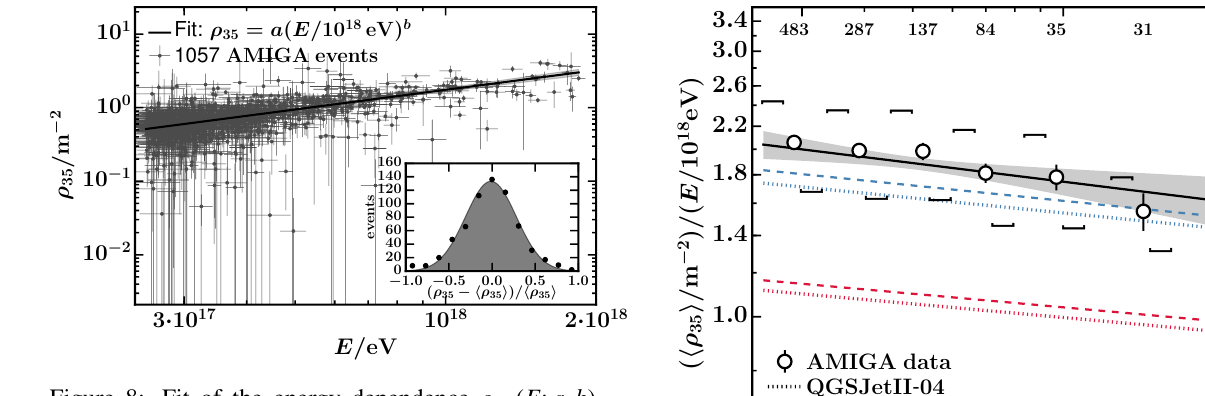
Figure 8: Fit of the energy dependence ρ 35 ( E ; a , b ) = a ( E / 10 18 eV ) b in the energy range 10 17 . 4 − 10 18 . 3 eV. Ver- tical and horizontal error bars for single events correspond to the statistical errors of the reconstructed muon densi- ties and SD-reconstructed primary energies. The inset plot shows the distribution of the normalized residuals.